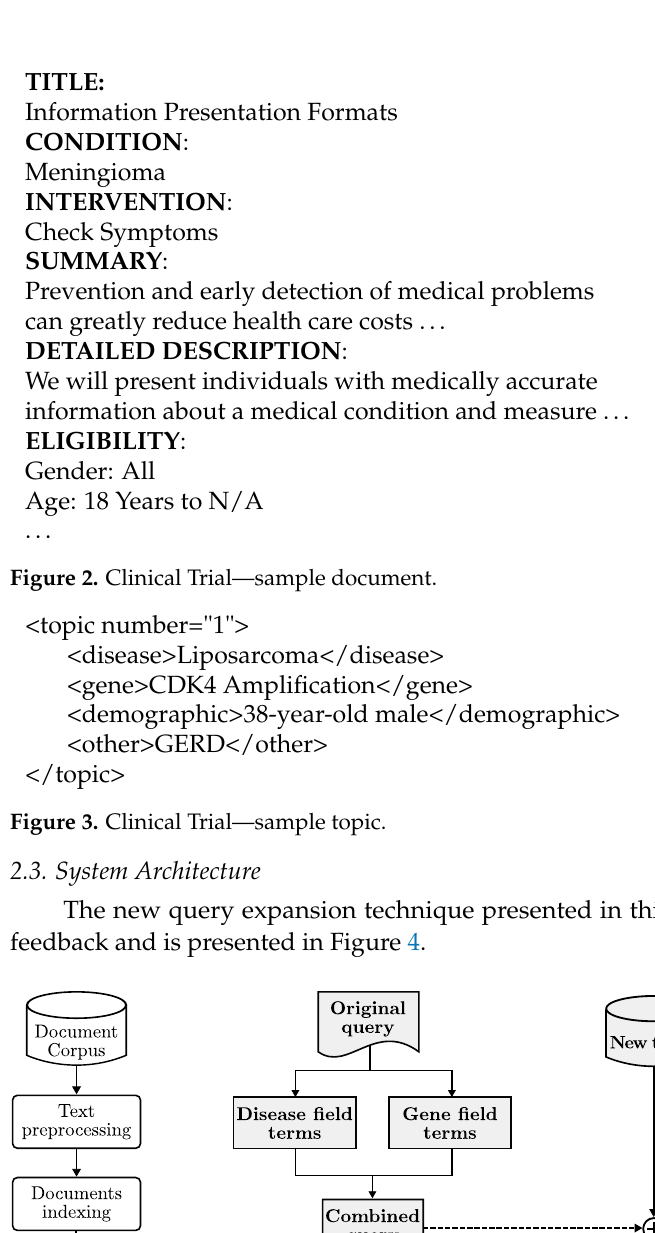
Figure 2. Clinical Trial—sample document.